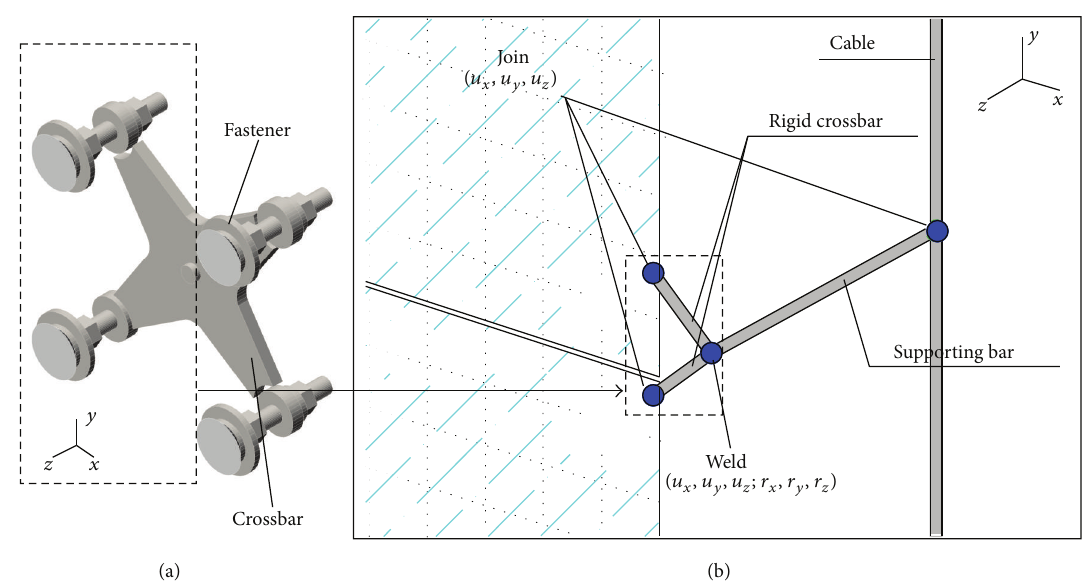
Figure 8: Example of point-supported glass panel. (a) Typical “spider” connector and (b) corresponding geometrically simplified FE model